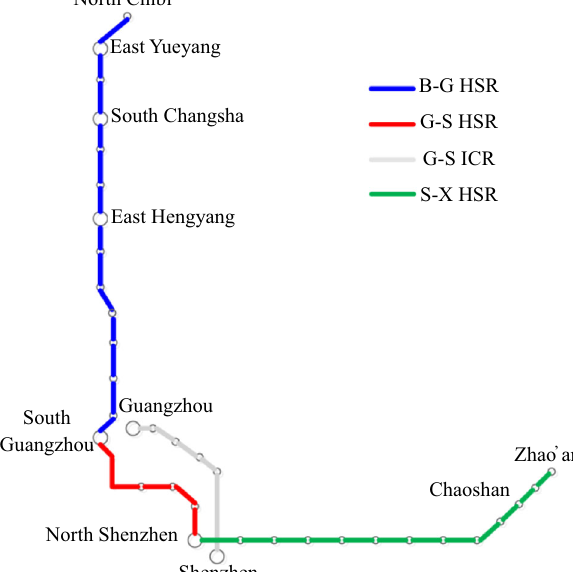
Fig. 1 Schematic of four HSR lines